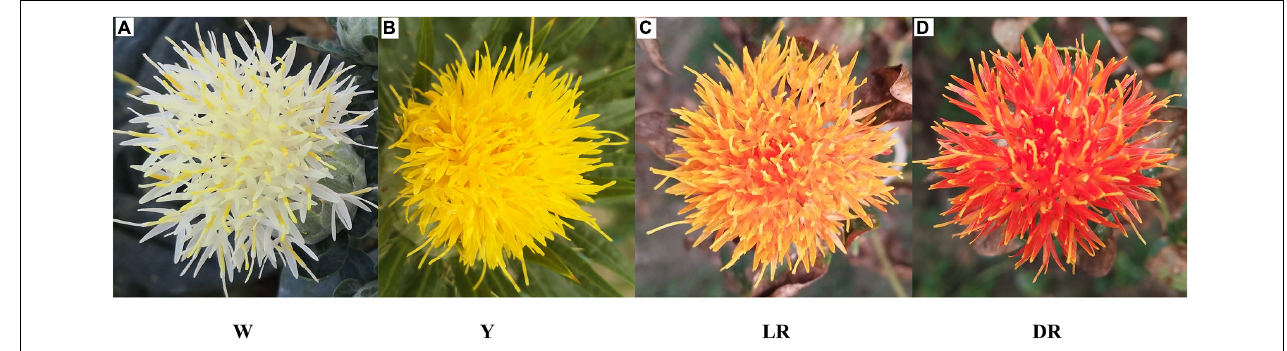
FIGURE 2 | Four safflower cultivars used in this study. (A) The white color of safflower, W means white. (B) The yellow color of safflower, Y means yellow. (C) The light red color of safflower, LR means light red. (D) The deep red color of safflower, DR means deep red.